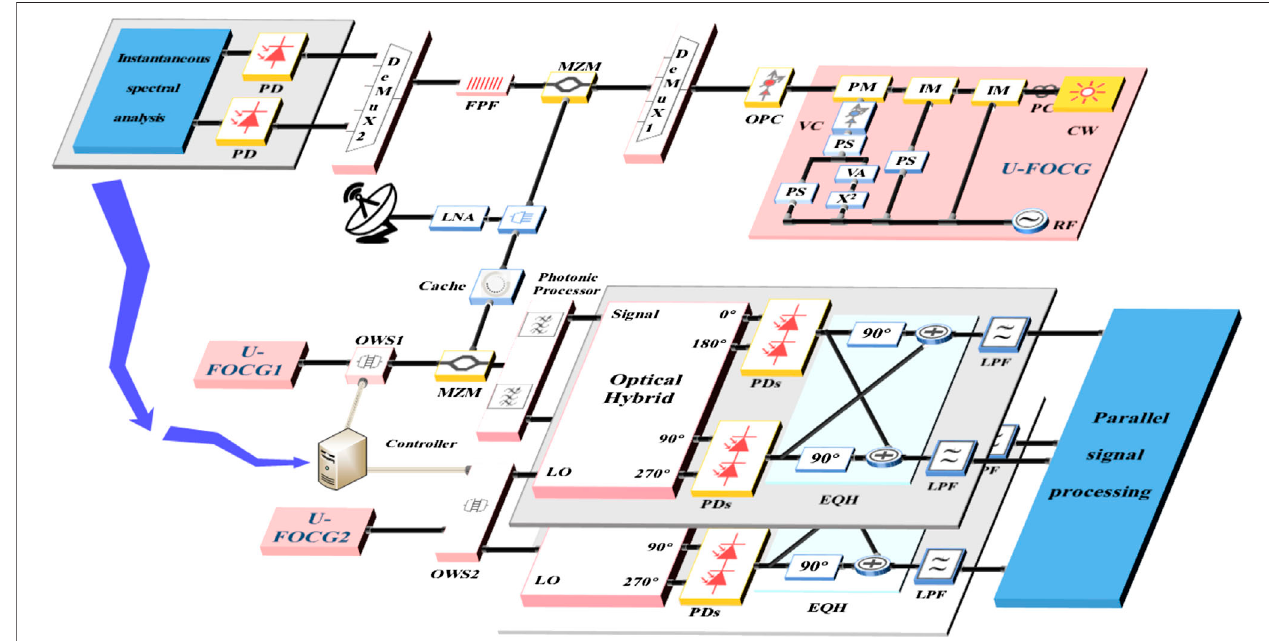
FIGURE 1 | Schematic diagram of the proposed photonics-assisted channelized receiver based on the spectrum analysis and the coherent channelization for multi-bandmicrowavesignals.U-FOCG, ultra- fl at opticalcombgenerator;OPC,opticalpower controlmodule;DeMux, demultiplexer; MZM,Mach-Zehndermodulator;